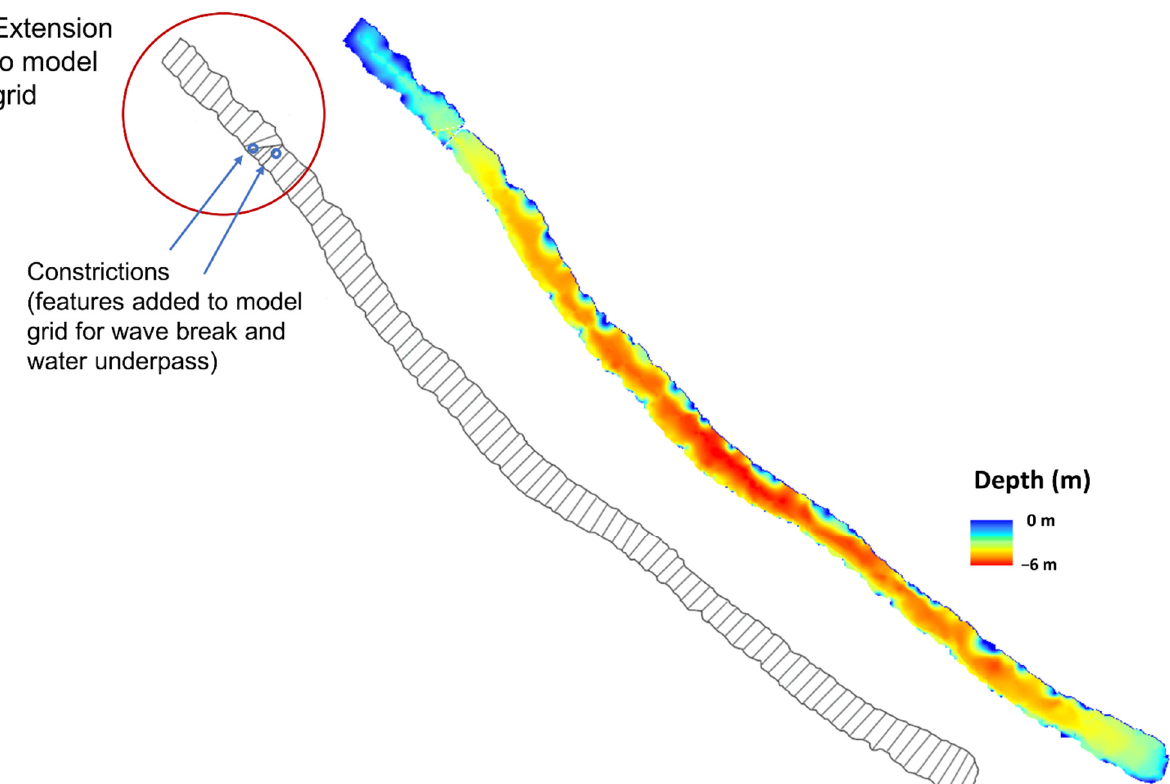
Figure 2. Left: Model grid with longitudinal segmentation. The upstream area in the red circle is the newly extended section of the model. Right: New digital elevation model of BPL including the upper shallow section of lake. Depths are shown relative to operating full supply level.